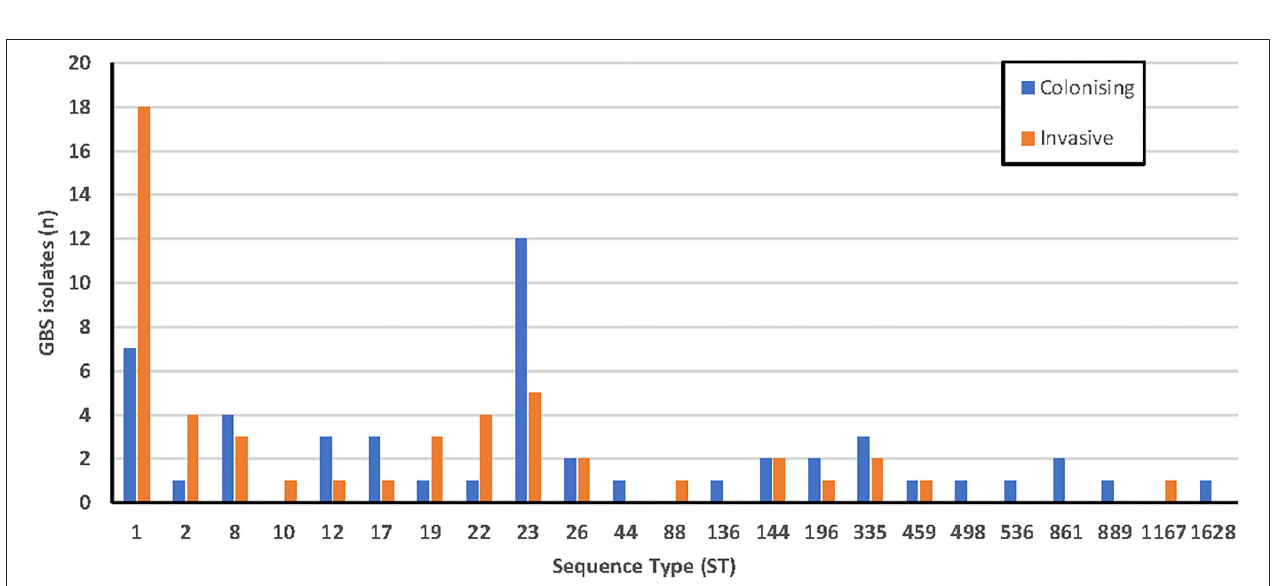
FIGURE 2 | Sequence types of colonizing ( n = 50) and invasive ( n = 50) GBS isolates using MLST.